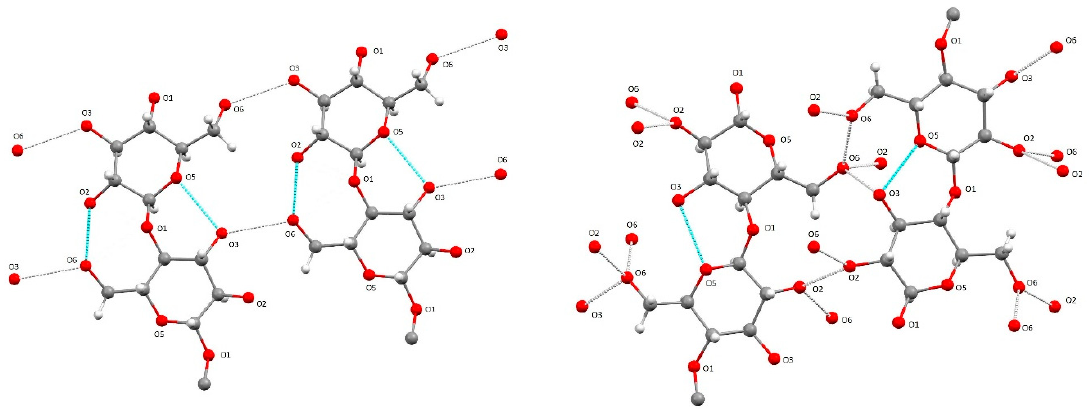
Figure 7. Patterns of inter- and intramolecular bonds in cellulose I β ( left ) and II ( right ). The cyan and light green dotted lines indicate intra- and intermolecular hydrogen bonds, respectively.